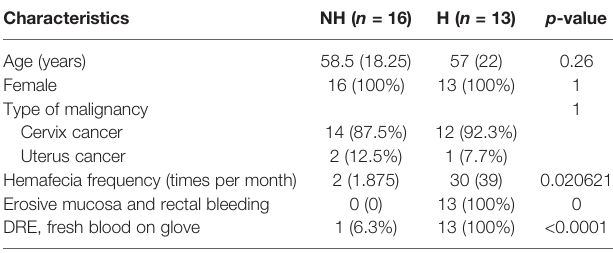
TABLE 1 | Clinical characteristics of the